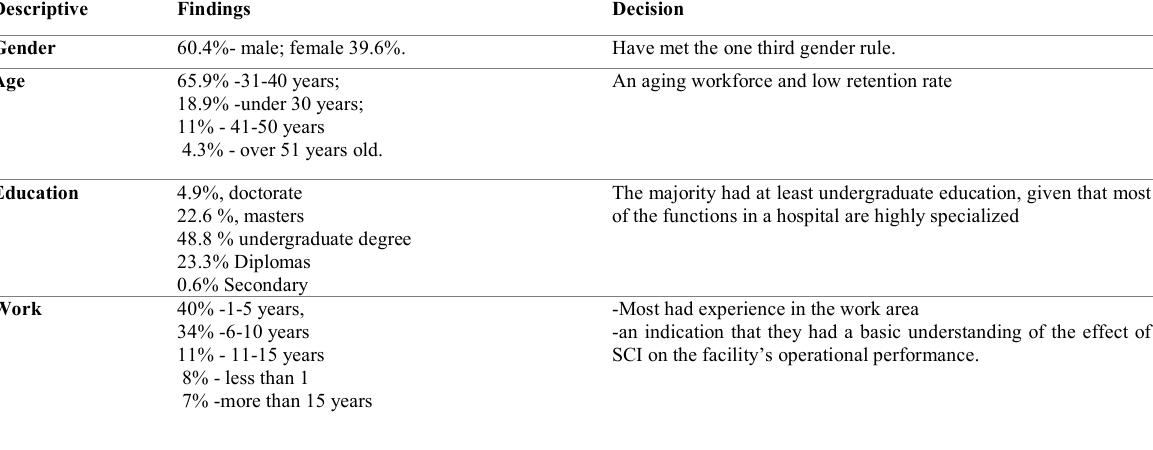
Table 1: Summary of The Demographic Information